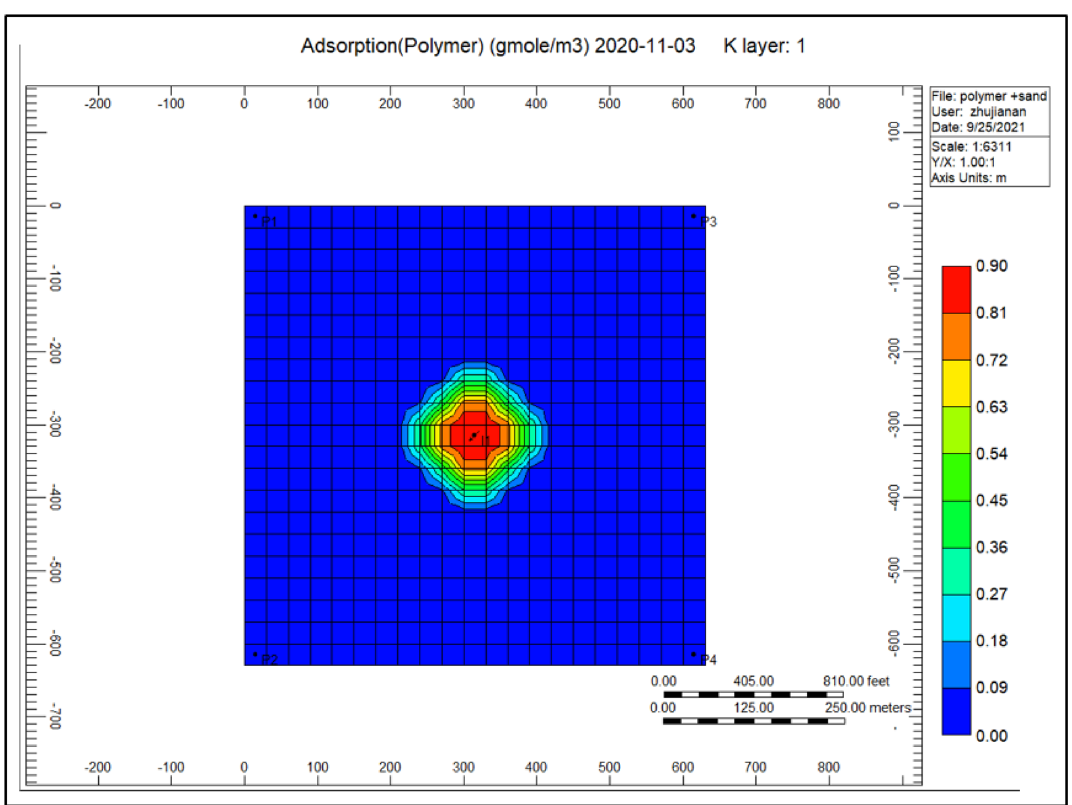
Figure 19. Indicates the polymer adsorption through the polymer sand plug model CMG STARS 2017.10 URL: https:// www. cmgl.